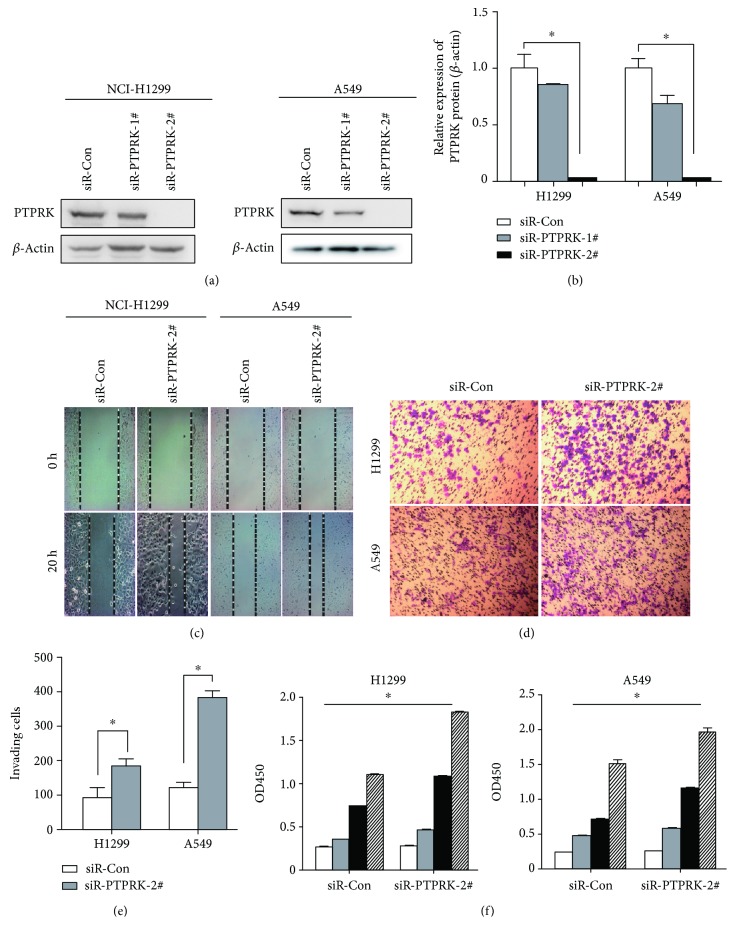
PTPRK knockdown promotes the cell proliferation, migration, and invasion ability in H1299 and A549 cells. (a) Western blotting analysis protein H1299 and A549 cells transfected two chemically synthesized siRNAs. (b) Quantitative analysis of PTPRK protein levels was calibrated with beta-actin levels of each sample from (a). (c) Representative micrographs of wound healing assay of the H1299 and A549 cells transfected with PTPRK siRNA#2 or NC. Wound closures were photographed at 0 h and 20 h after wounding. (d) Representative micrographs of Transwell invasion assay of the H1299 and A549 cells transfected with PTPRK siRNA#2 or NC. (e) Quantification of indicated invading cells in five random fields analyzed by the Transwell assays. Values represent the mean ± SD from three independent measurements. (f) Cell proliferation assays. H1299 and A549 cells were transfected with PTPRK siRNA#2 or NC. Cells were counted by a CCK-8 kit after 6 h, 24 h, 48 h, and 72 h. Values represent the mean ± SD from three independent measurements.